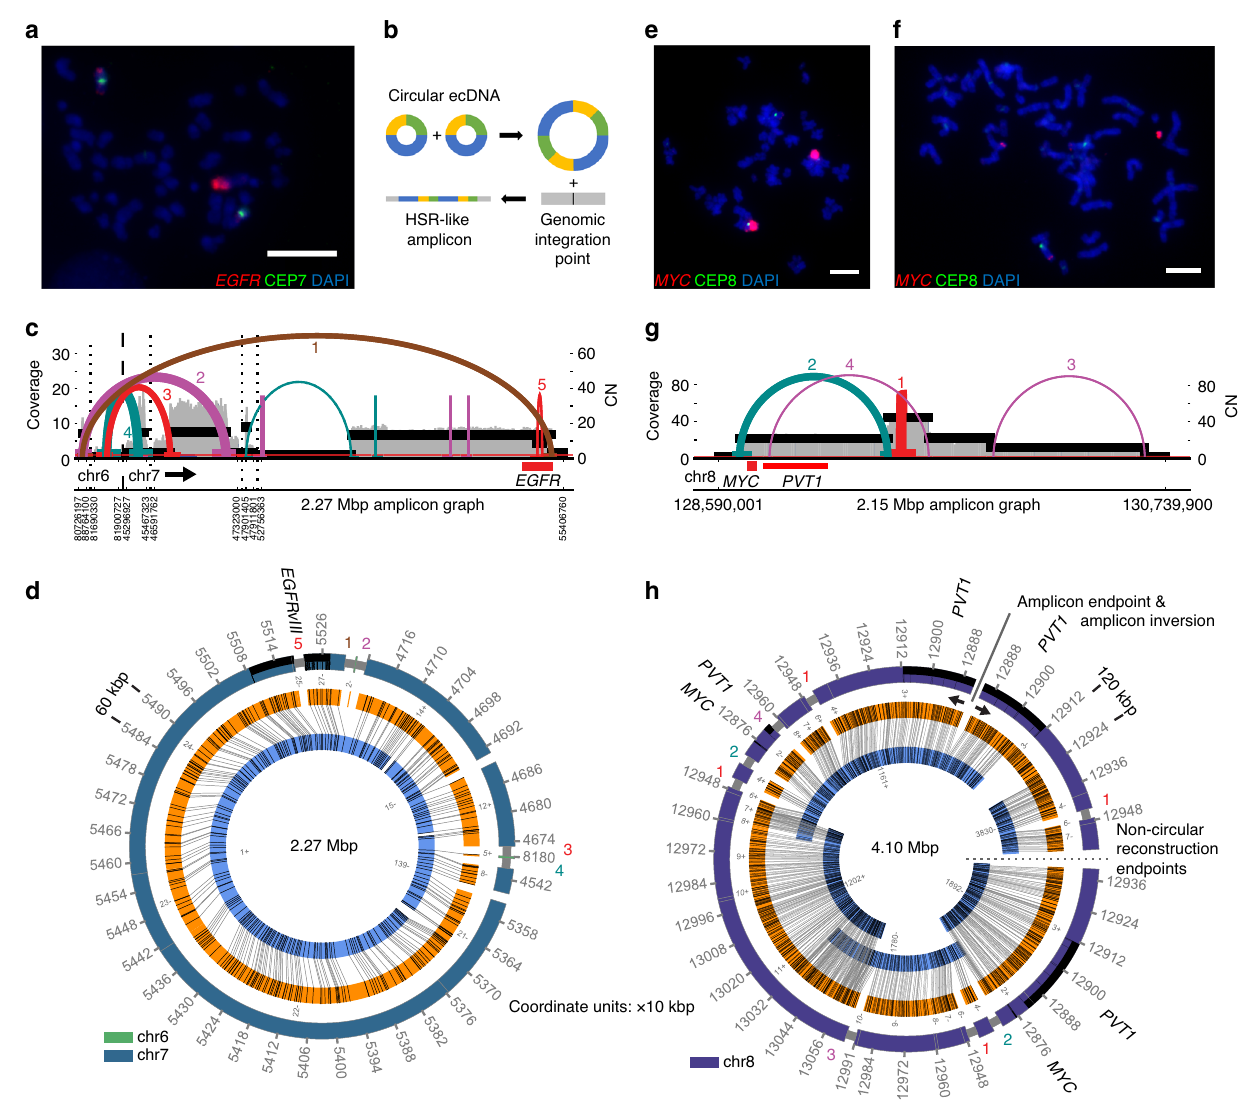
Fig. 2 Reconstruction of extrachromosomal DNA (ecDNA). a FISH with DAPI (4 ′ ,6-diamidino-2-phenylindole)-stained metaphase chromosomes in HK301 showing an HSR-like amplicon containing EGFR . Scale bar indicates 10 µ m. b Theoretical model for the integration of circular extrachromosomal DNA into HSR-like amplicons, preserving the structure of breakpoint graph. c AA-generated breakpoint graph for HK301 containing EGFR and segments from chr6. The coloring of the graph edges represents the orientation of the junction between the two segments. Edge thickness indicates AA-estimated breakpoint copy number. Vertical dashed lines separate segments from different chromosomes while dotted lines indicate distinct genomic regions from the same chromosome. Numbering of breakpoint edges corresponds with AR reconstruction breakpoint numbering. d Cyclic AR reconstruction of HK301 amplicon containing EGFRvIII . Breakpoint graph edges supported by the AA graph are numbered in a manner corresponding to the numbering in panel ( c ). e FISH with DAPI-stained metaphase chromosomes in NCI-H460 shows HSR-like MYC amplicon. Scale bar indicates 7.3 µ m. f FISH with DAPI-stained metaphase chromosomes in NCI-H460 showing an extrachromosomal MYC amplicon. Scale bar indicates 7.3 µ m. g AA-generated breakpoint graph for NCI-H460 containing MYC and PVT1 . h AR reconstruction of the NCI-H460 amplicon. Indicated in this fi gure is an amplicon inversion point (top right) where the reconstruction explaining the full amplicon ends, and then the structure begins to repeat in the opposite direction (solid line & opposing black arrows). Also indicated is an endpoint for the non-circular reconstruction (center right) where the AR reconstruction and full amplicon structure both stop (dotted